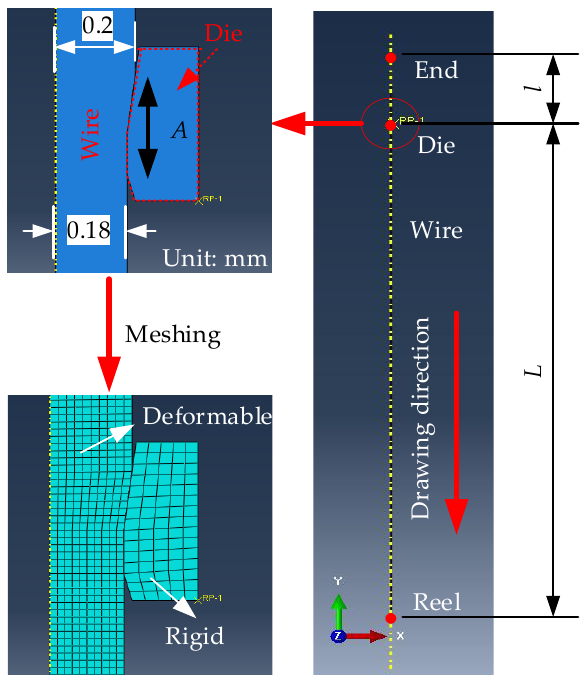
Figure 1. Simulation settings and FE model of single-die ultrasonic wire drawing.